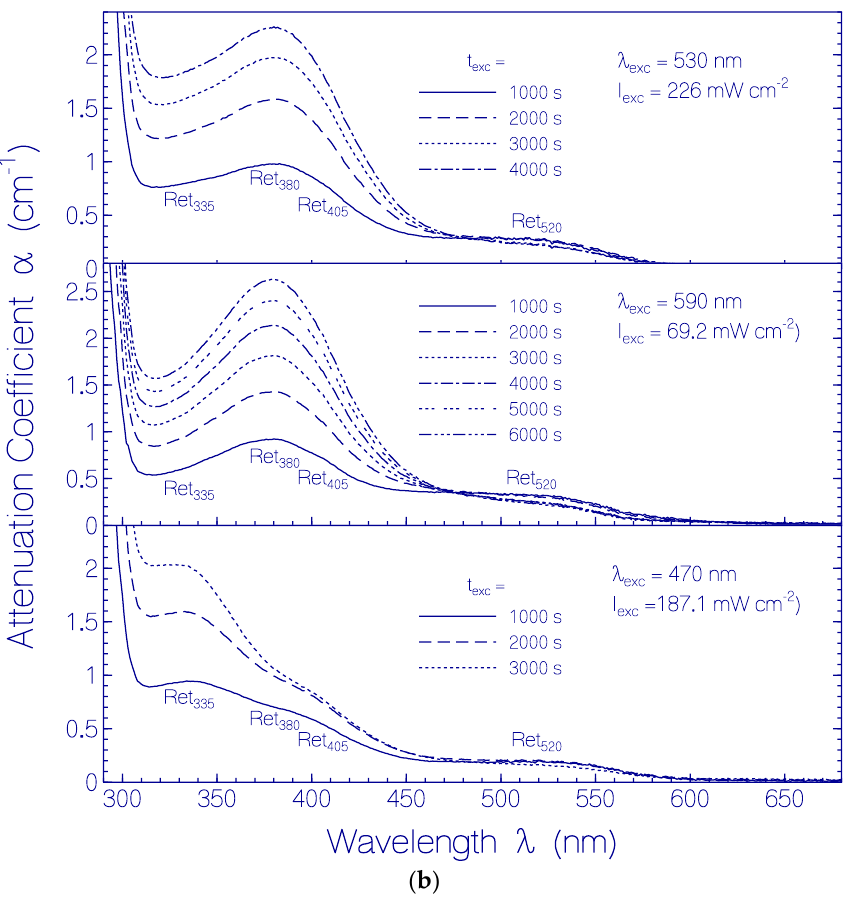
Figure 11. ( a ) Attenuation coefficient spectra of dark-adapted CaRh da in pH 7.3 HEPES/MOPS buffer before light exposure ( t exc = 0) and after light exposures with LED 530 nm (top part), LED 590 nm (middle part), and LED 470 nm (bottom part); ( b ) Attenuation coefficient spectra of formed photoproducts of CaRh in pH 7.3 HEPES/MOPS buffer due to light exposure with LED 530 nm (top part), LED 590 nm (middle part), and LED 470 nm (bottom part). Input excitation intensities I exc and durations of light exposure t exc are listed in the sub-figures of ( a ) and ( b ).